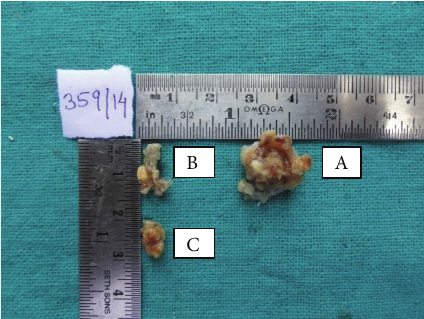
Figure 4: Gross specimen showing asymmetrical yellow colored 3 soft tissue bits received (A: 1.5×1.5 cm, B: 0.9×0.5 cm, and C: 0.6× 0.9 ).